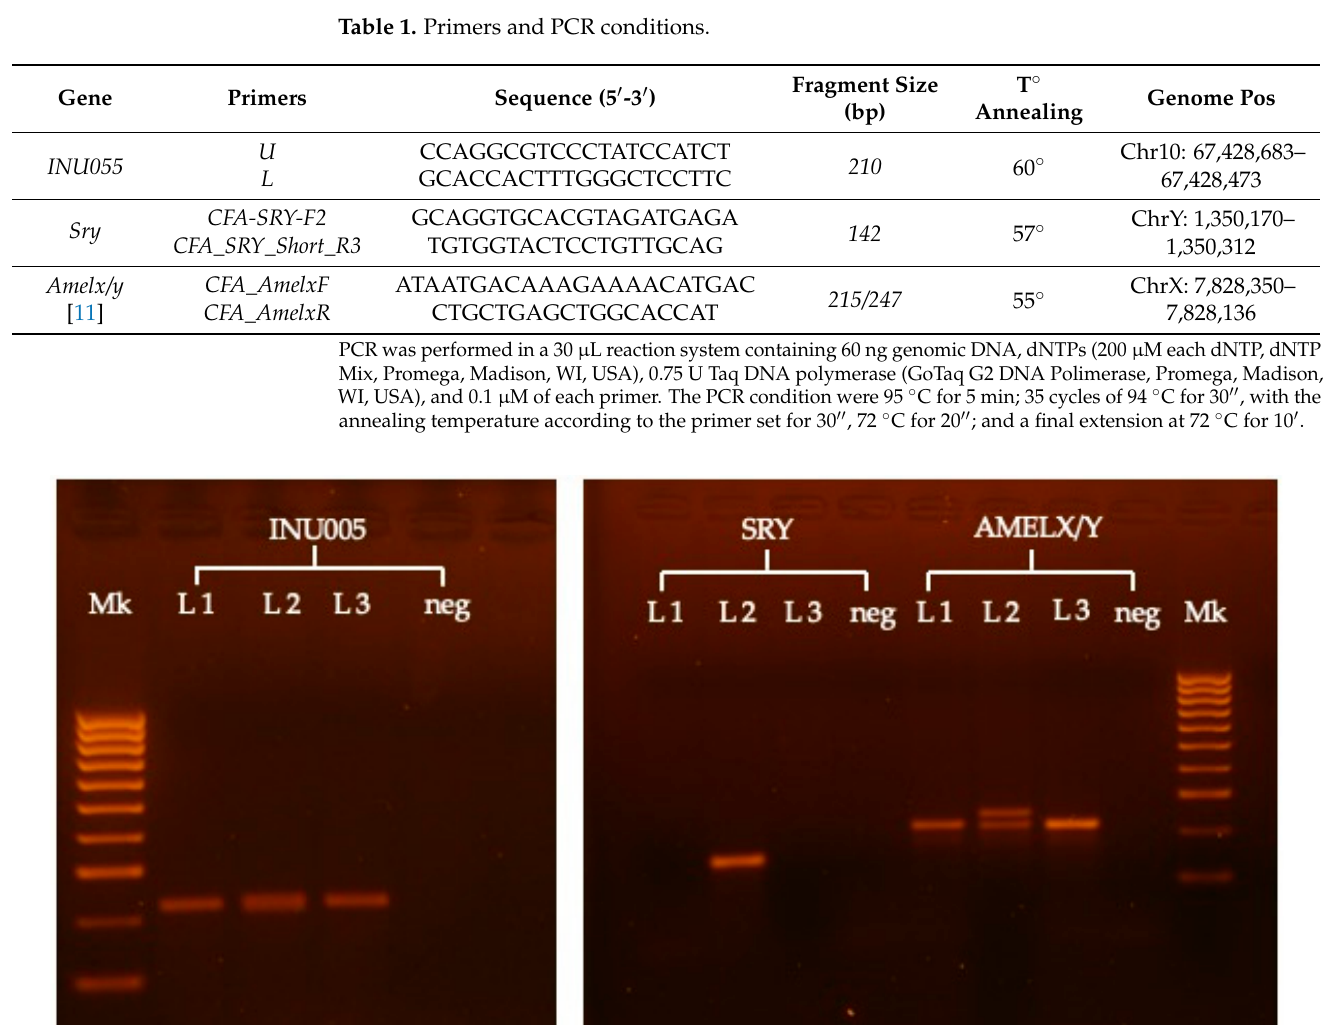
Table 1. Primers and PCR conditions.